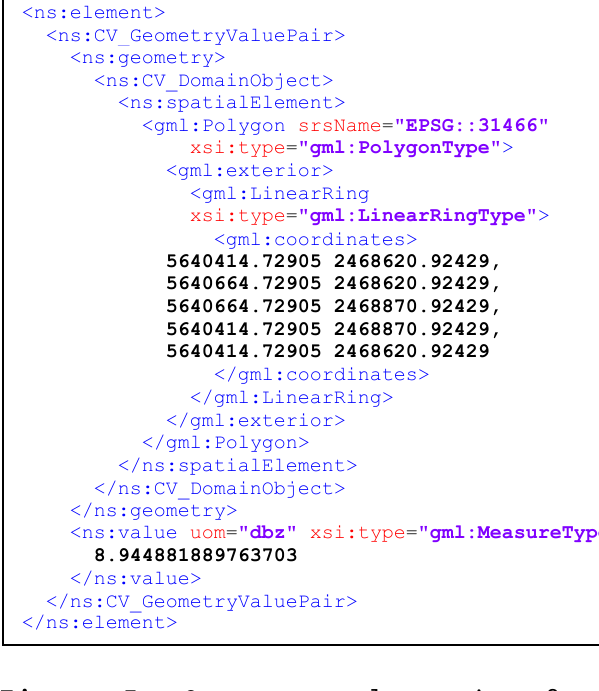
Figure 5. Geometry value pair of a raster mesh encode with the DiscreteCoverageObservation